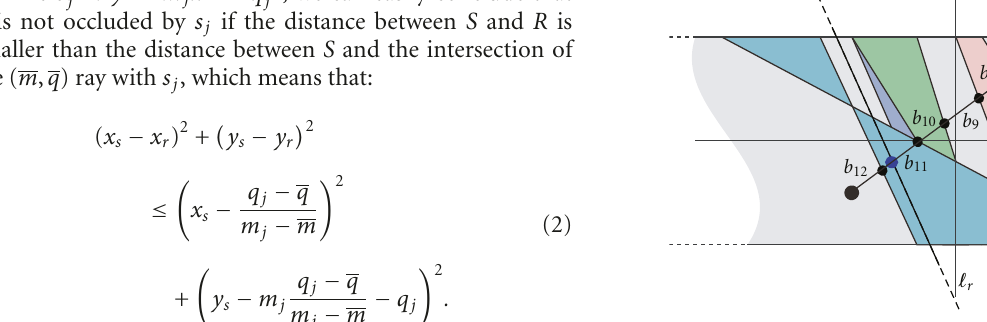
i ) y = m x ( i ) + q ( i ) j j : j , we can easily conclude that